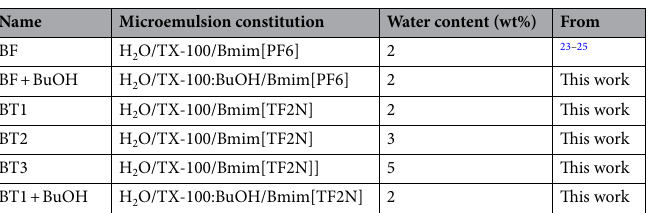
Table 1. Microemulsion